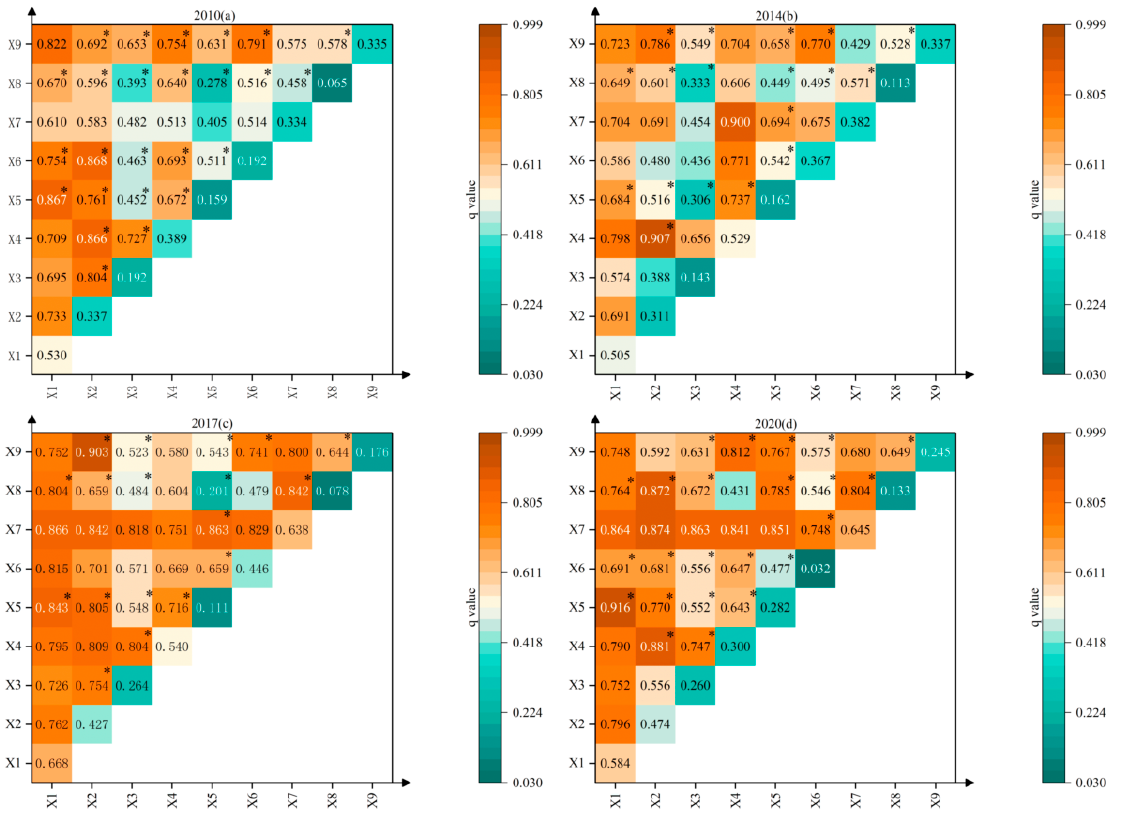
Figure 8. Interaction detector results of EWP in the TGRA in 2010, 2014, 2017, and 2020. Note: * is non-linear enhancement, the rest is two-factor enhancement. non-linear enhancement, the rest is two-factor